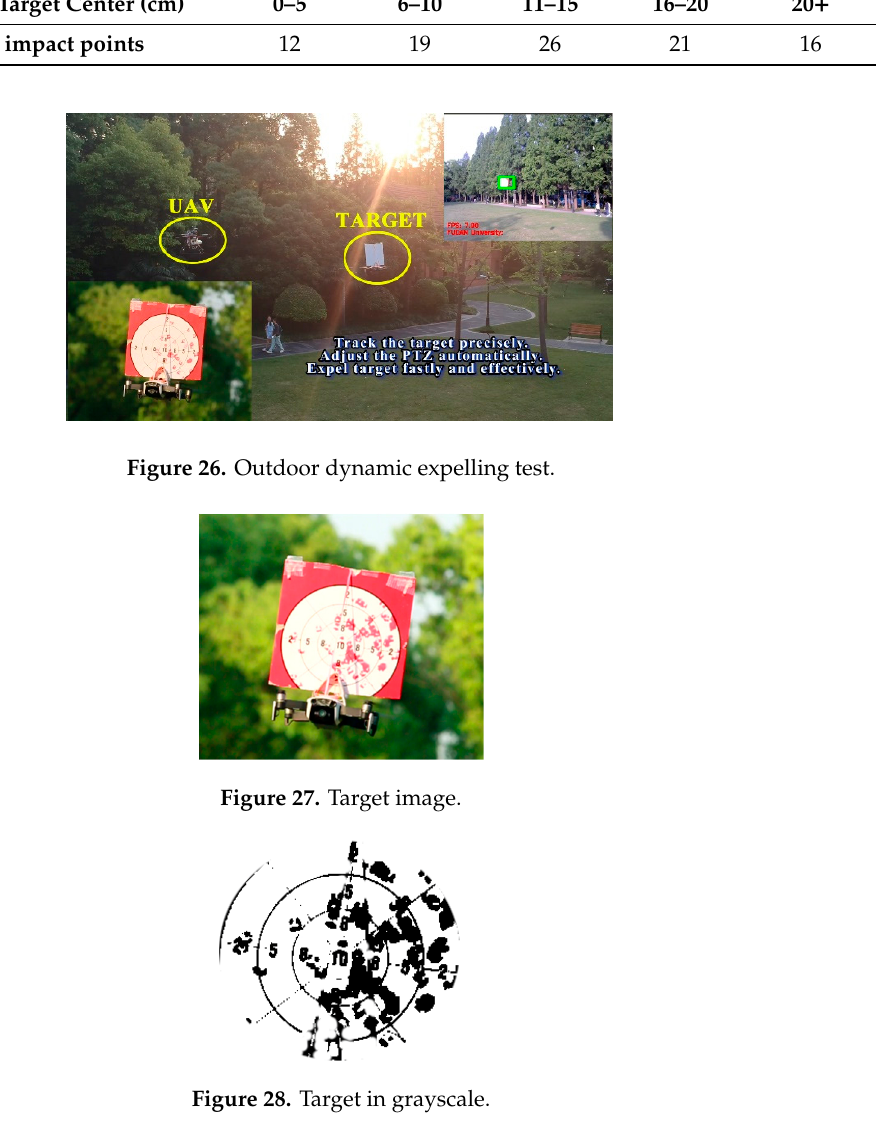
Table 7. Outdoor accuracy test.